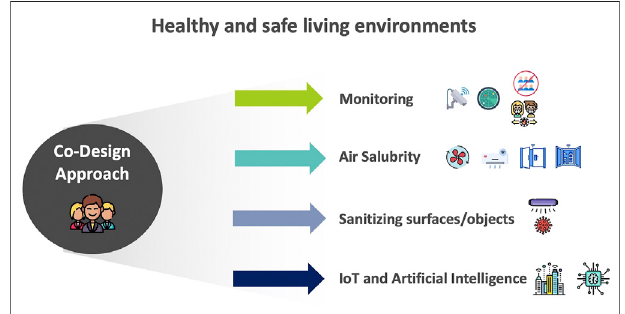
FIGURE 1 | Summary of SAFE PLACE methodological approach and hardware/software